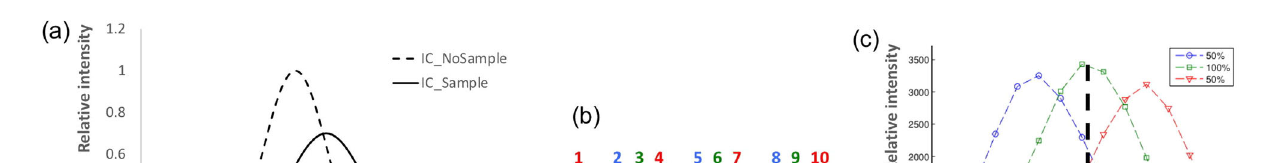
c shows part of the interior of the cabinet in which detector, detector and sample masks,and sample stagearevisible.The x-ray source (notvisible)is tothefar right of the components shown in panel c .